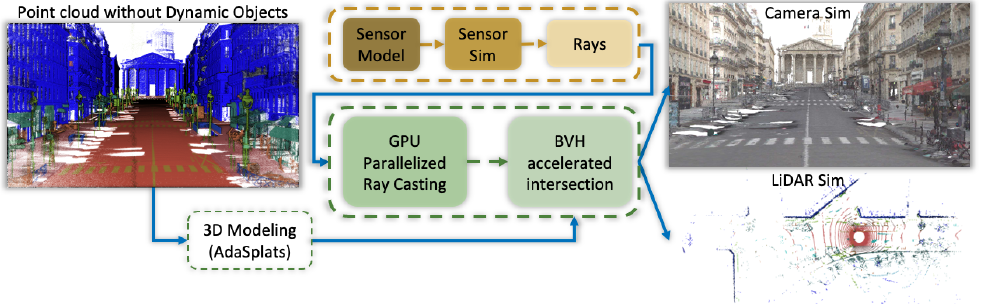
Figure 5. Our pipeline is split into different modules. The first generates accurate 3D modeling of the static environment using our adaptive splatting method. The second module takes the sensor model as input and simulates the sensor, including but not limited to camera and LiDAR, and generates the corresponding rays. In the third module, the rays are cast in parallel using the GPU architecture, then a bounding volume hierarchy (BVH) structure containing the generated splats is traversed, and ray–splat intersection point or color information is reported to generate the LiDAR or camera output,